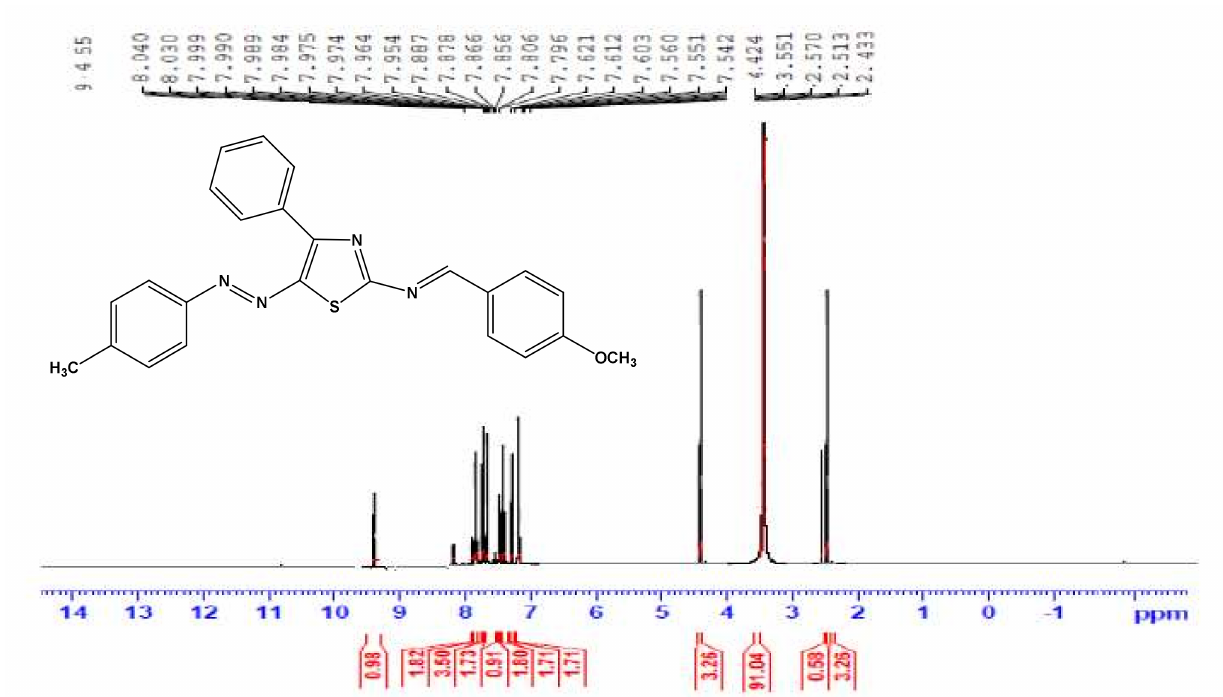
Chart 1. 1 H-NMR of compound 3e as a representative example. More spectra are available on line as Supplementary Materials: Figure S1: IR of compound ( 3a ), Figure S2: 1 H-NMR of compound ( 3a ), Figure S3: 13 C-NMR of compound ( 3a ), Figure S4: MS of compound ( 3a ), Figure S5: IR of compound ( 3e ), Figure S6: 1 H-NMR of compound ( 3e ), Figure S7: 13 C-NMR of compound ( 3e ), Figure S8: MS of compound ( 3e